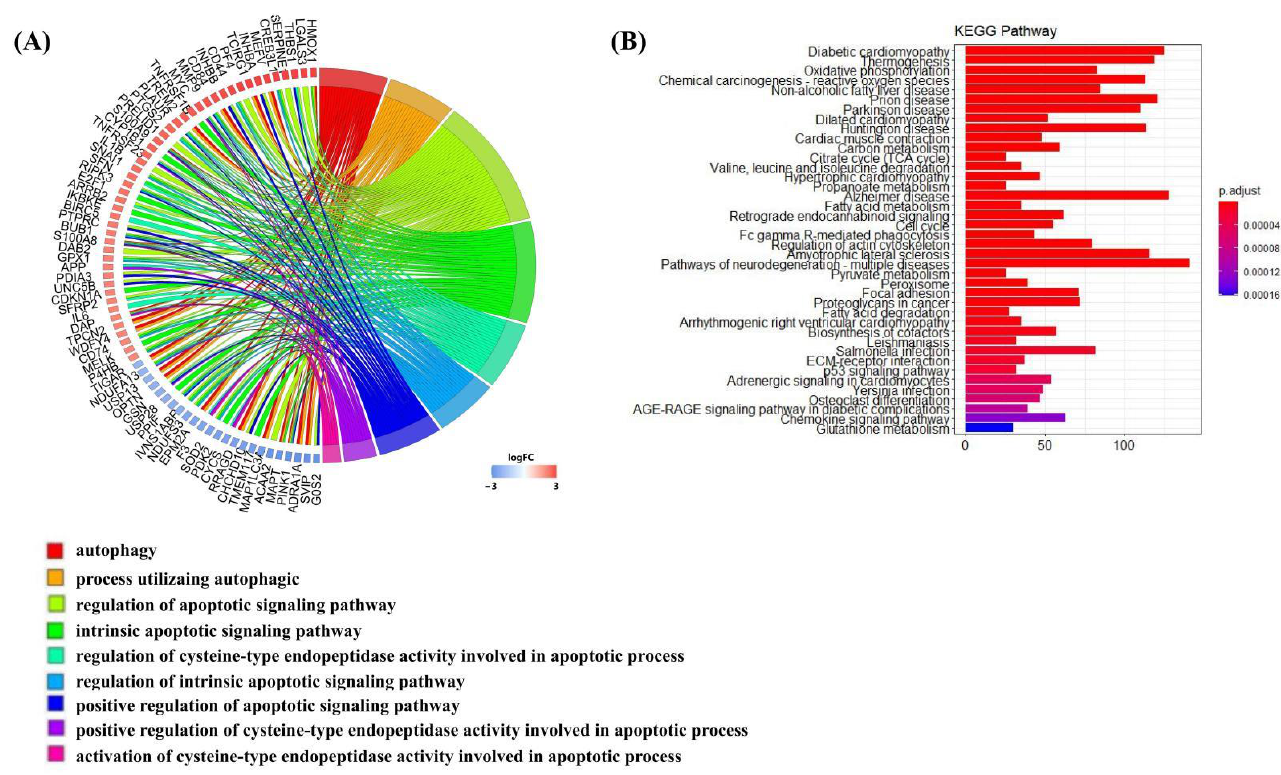
Figure 6. Enrichment analysis of DEGs on day 3 post-MI in mRNA-seq data. ( A ) Circle diagram of the biological analysis of DEGs on day 3 post-MI. Different color blocks represent different biological processes. The circle diagram below shows the biological processes associated with autophagy and apoptosis. ( B ) Bar chart of the KEGG analysis of significant DEGs on day 3 post-MI. The first 40 pathways are shown in the figure, and the p cut-off value of all pathways is 0.05.